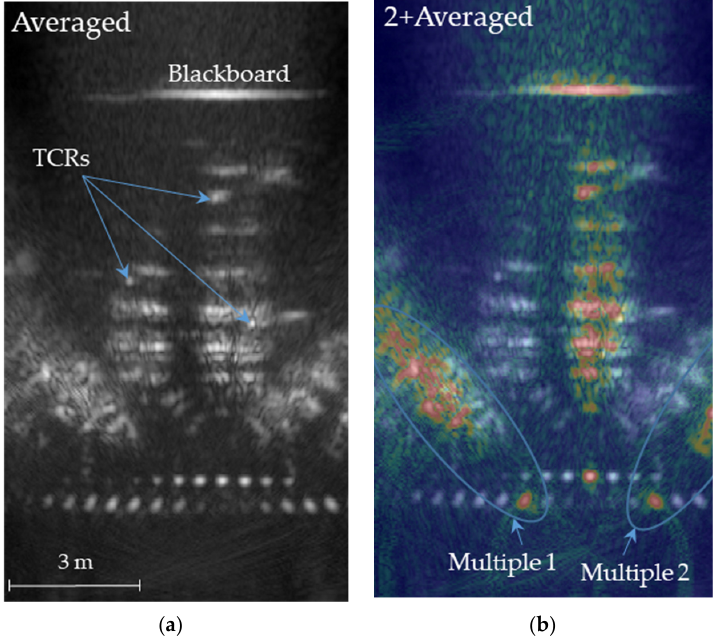
Figure 4. Multistatic GB-SAR images: ( a ) An averaged image of all the images with various stationary antennae in Figure 3. ( b ) The scene #2 image in RGB color overlying the averaged image, showing two azimuth multiples.